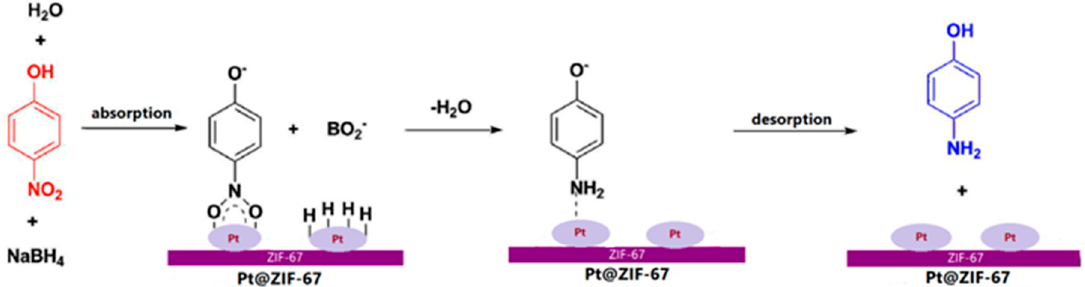
Figure 9. The mechanism of reduction reaction 4-nitrophenol by Pt@ZIF-67.